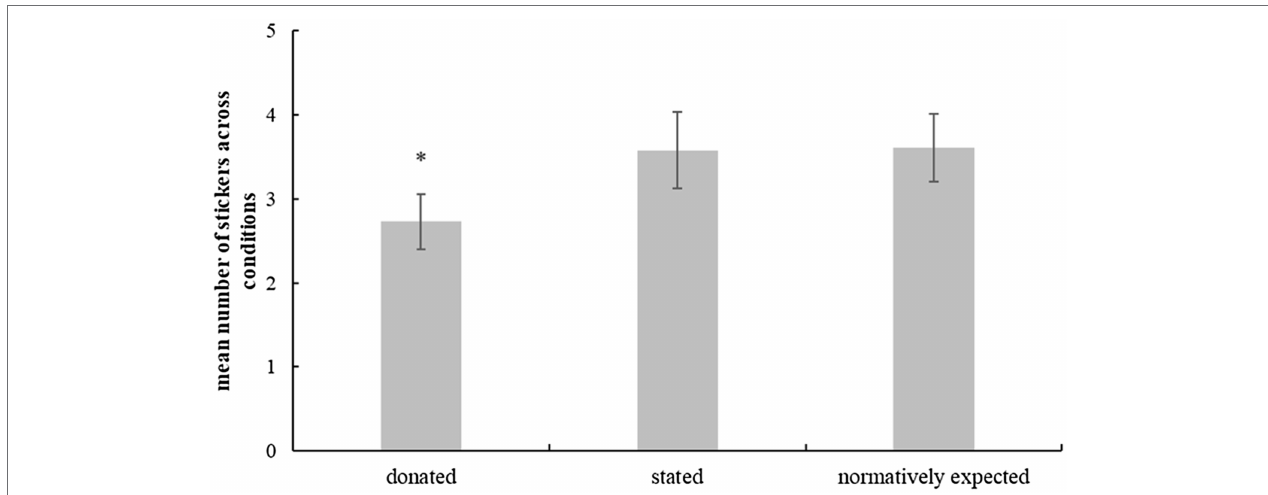
FIGURE 2 | Mean number of donated stickers across conditions, mean number of stickers stated in the test-questions and normative expectation about number of donated stickers. Included were onlychildren who passed the memory check ( n = 34). Error bars depict standard error of the mean. * Significantly different from both other bars, p <